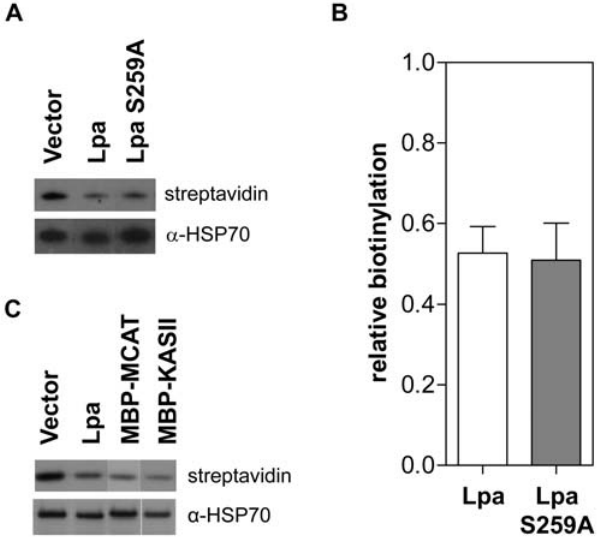
Figure 3. Effect of protein expression on biotinylation. ( A ) Affinity blot analysis of biotinylation in E. coli BL21 cells expressing Lpa and Lpa S259A. Samples were normalized by OD 600 and the protein extracts from whole cell lysate were separated by SDS-PAGE and blotted onto nitrocellulose. The biotinylation status of the BCCP, the sole biotinylated protein in E. coli , was analyzed by streptavidin-HRP western blot. ( B ) Densitometry analysis of the biotinylation level in cells expressing Lpa and Lpa S259A. Streptavidin-HRP signal was normalized to the HSP70 loading control signal for each sample. Within each blot, the fraction of biotinylation relative to cells expressing vector alone was determined. Error bars represent the SEM for fraction of biotinylation for three independent western blots. ( C ) Affinity blot analysis of biotinylation in E. coli BL21 cells expressing Lpa and the unrelated proteins MBP-MCAT and MBP-KASII. Samples were analyzed by the methods described in part A of this figure.